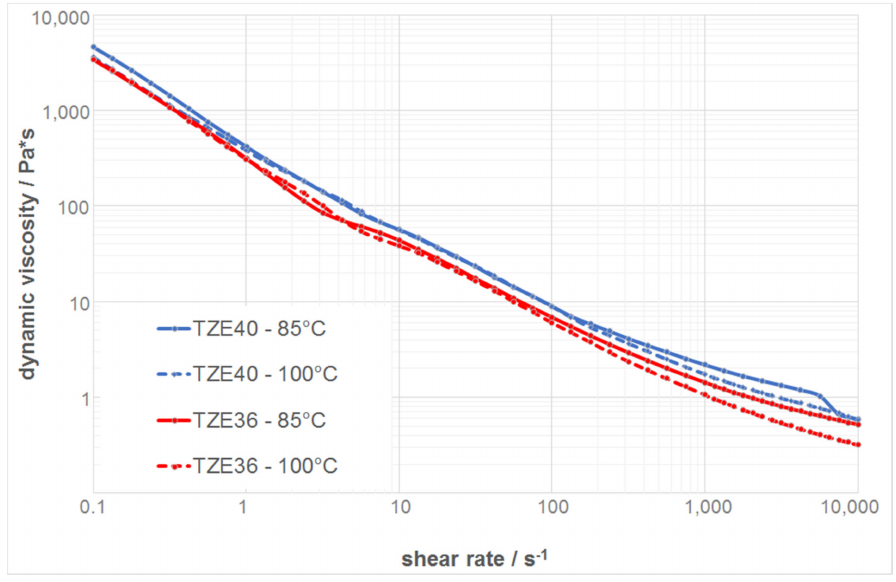
Figure 12. Rheological behavior of zirconia suspensions without any